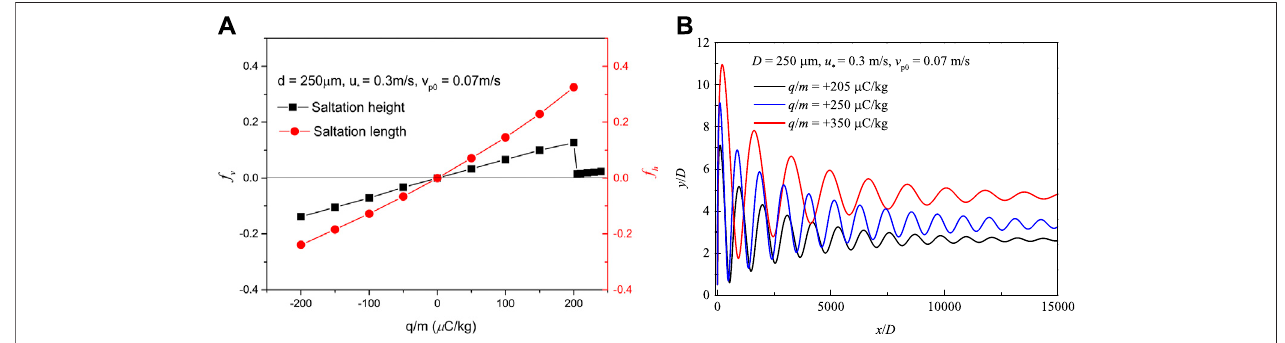
FIGURE 7 | (A) Dimensionless saltation height and length for different charge-to-mass ratios of particles. (B) Suspension particles ’ trajectories with high value of charge-to-mass.